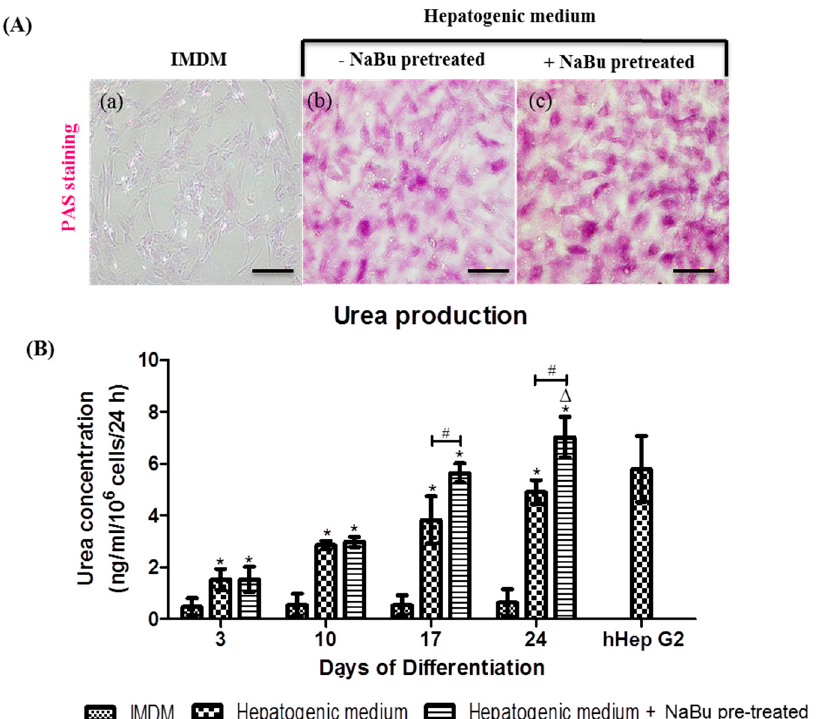
Figure 7. The functional evaluations of di ff erentiated human Wharton’s jelly–derived mesenchymal stem cells (hWJ–MSCs) with and without sodium butyrate (NaBu) pre-treatment with epidermal growth factor (EGF) and basic fibroblast growth factor (bFGF) supplementation. ( A ) Glycogen storage was characterized via Periodic acid–Schi ff (PAS) staining following the di ff erentiation period in di ff erentiated hWJ–MSCs with and without NaBu pre–treatment and EGF and bFGF supplementation on day 24 ( a – c ). (Original magnifications 100 × , bar = 100 µ m). ( B ) Urea production was assessed using a colorimetric assay in the di ff erentiated hWJ-MSCs with and without NaBu pre–treatment and EGF and bFGF supplementation after 24 day of di ff erentiation. hHepG2 cells were used as a positive control. The data are shown as the mean ± SD; * p < 0.05 compared to the control group. ∆ , represents significantly higher urea production ( p < 0.05) than that in other groups. # p < 0.05 compared to the significantly highest urea production